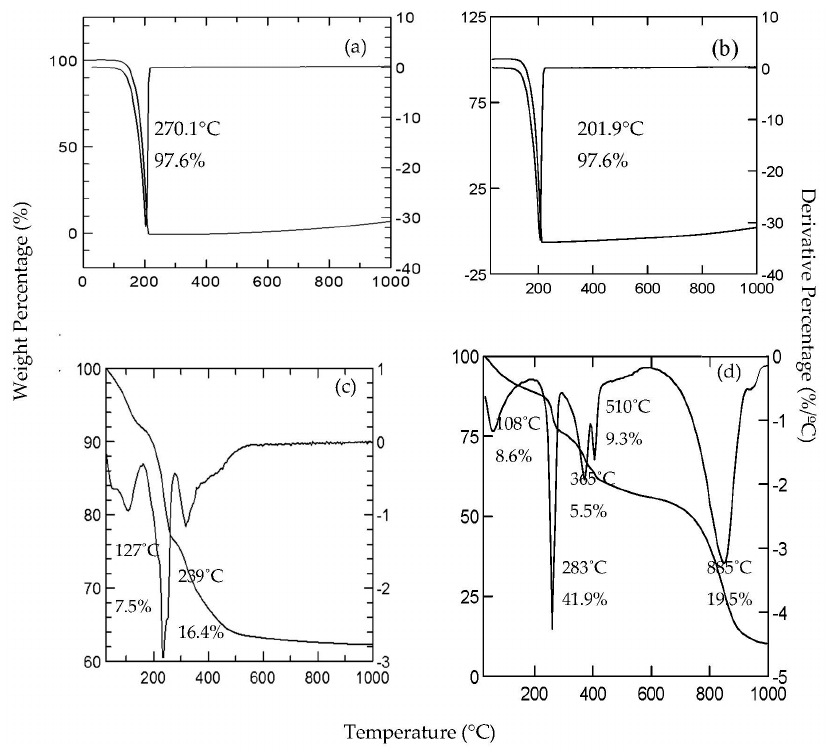
Figure 6. TGA/DTG analyses of ( a ) 3,4D, ( b ) TBA, ( c ) LDH and ( d )